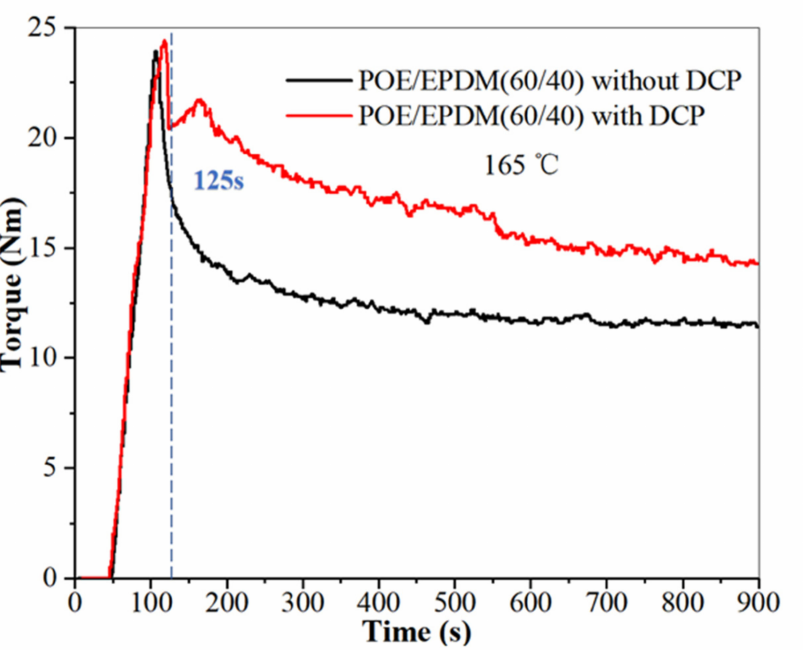
Figure 1. Variations of torque of POE/EPDM blends with and without DCP at 165 ◦ C in a torque